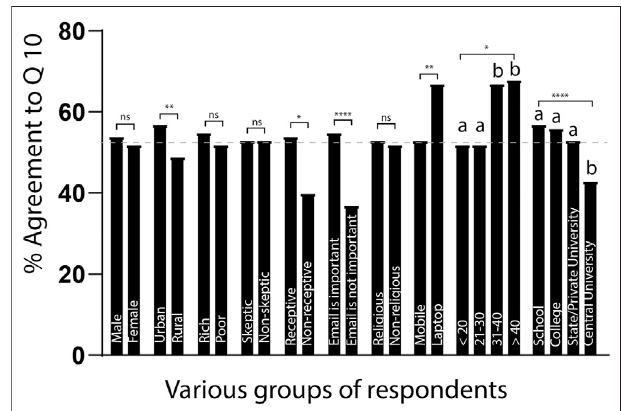
FIGURE 3 | Per cent agreement to Q10 as a factor of various independentvariables.Thedashedlineingreyrepresentstheoverallmeanper cent agreement (53.4%). Level of signi fi cance is presented above the column graphs. ns (cid:1) not signi fi cant, * p < 0.05, ** p < 0.01, *** p < 0.001, *** p < 0.0001. Common lowercase letters on the top of plots identify statistically homogenous groups (post-hoc based on Bonferroni method). Refer text for types of tests